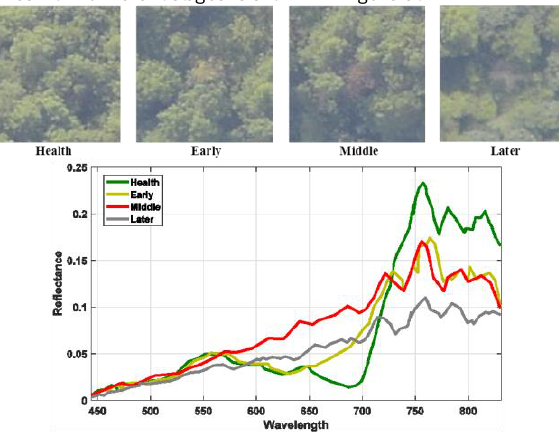
Figure 3. Reflectance spectra profile in four